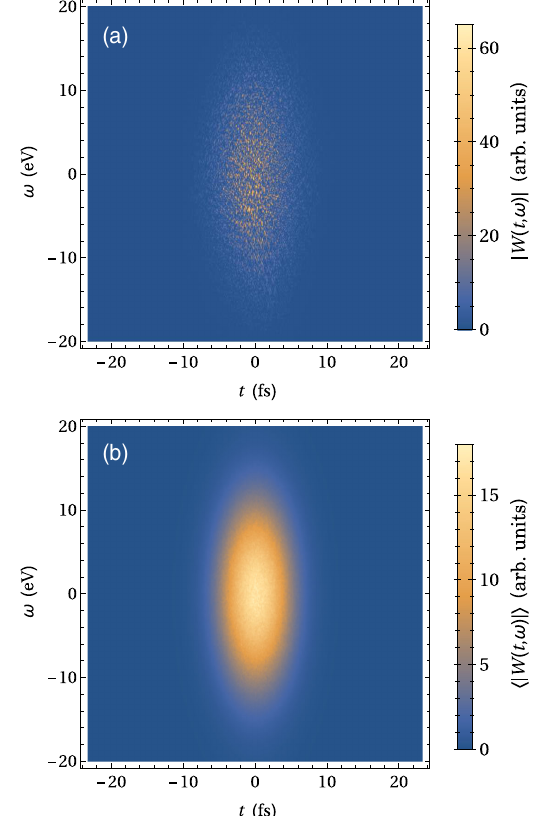
FIG. 3. Wigner spectrogram [Eq. (11)] for the same pulse parameters as in Fig. 2. (a) Modulus of the Wigner spectrogram of a single stochastic pulse realization and (b) mean modulus of the Wigner spectrogram averaged over 500 pulse